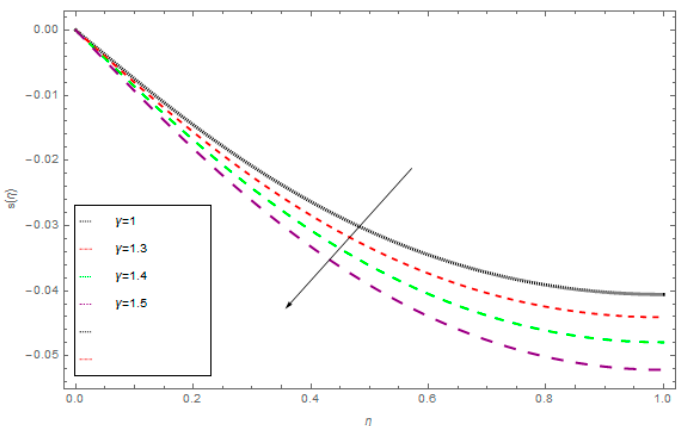
Ω = 1, ρ = 1, σ = 0.5, k = 1, M = 1. Coatings 2019 , 9 , x FOR PEER REVIEW